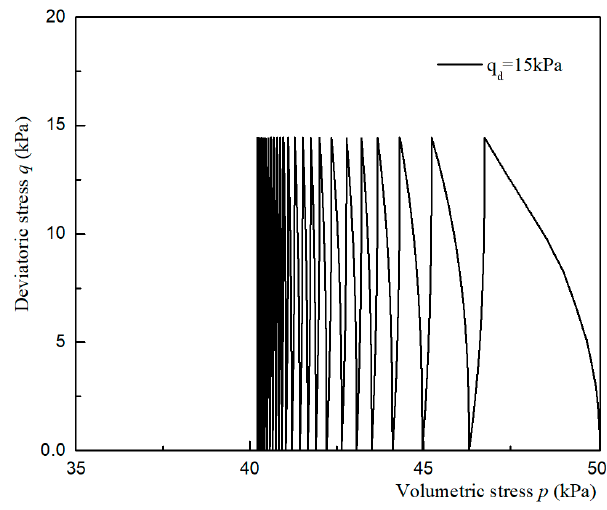
Figure 8. Effective stress path under typical conditions.